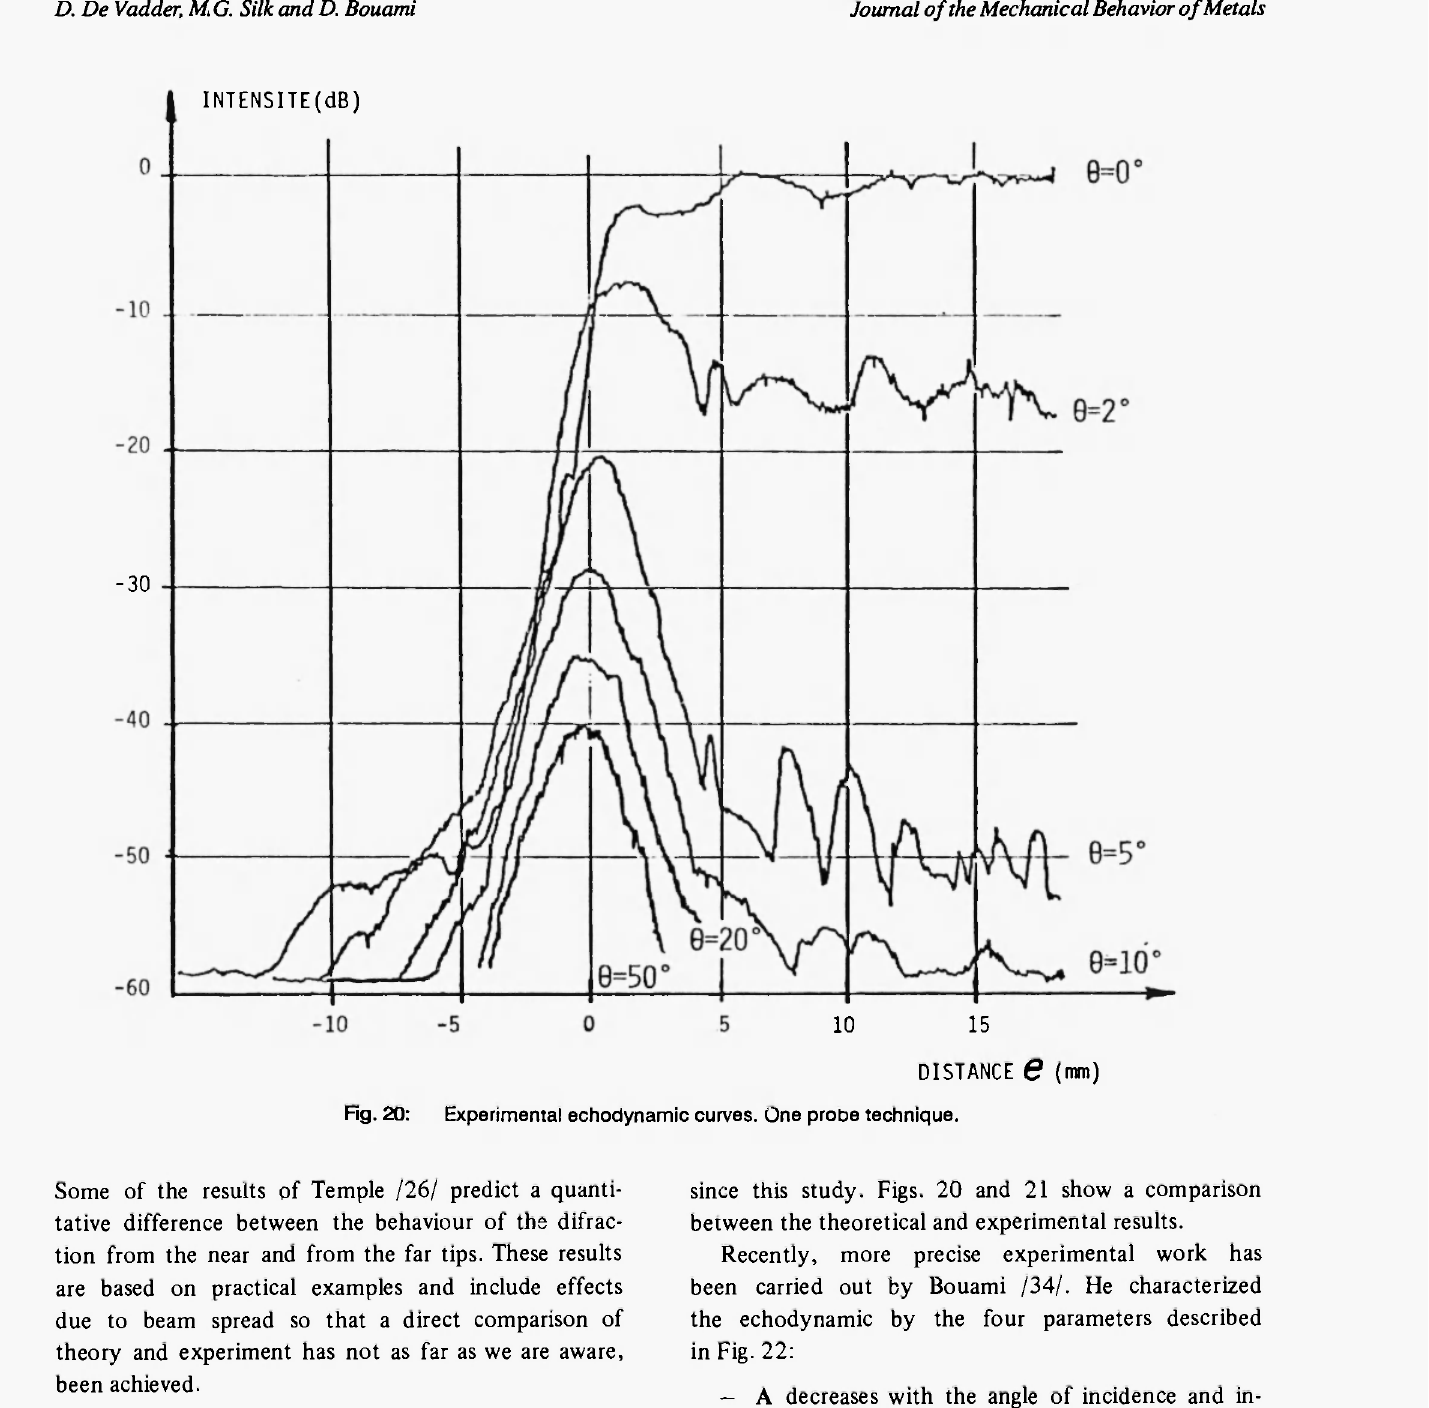
Fig. 20: Experimental echodynamic curves. One prooe